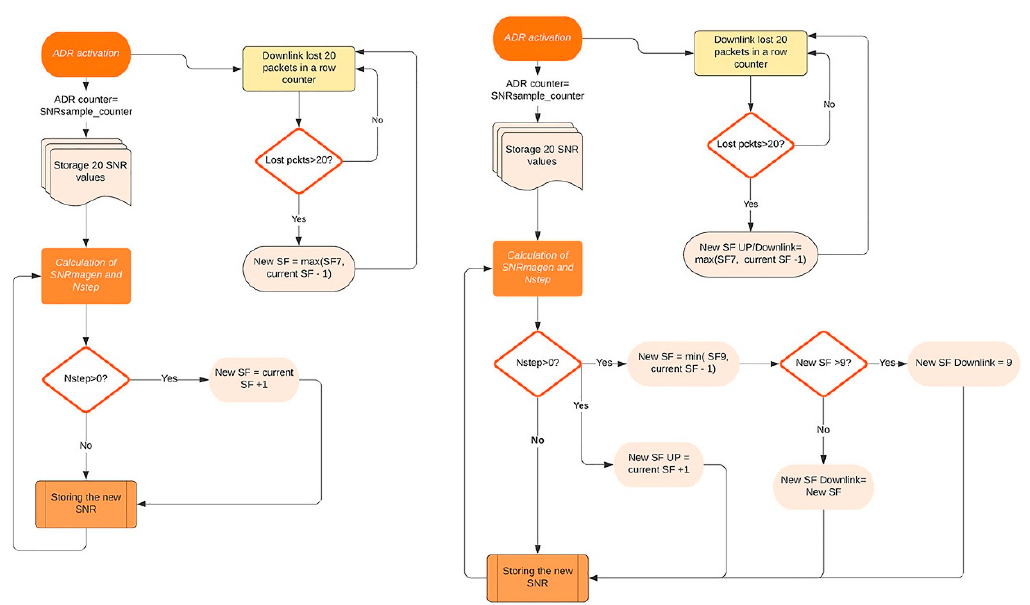
Figure 6. State machine for implemented adaptive data rate (ADR) in end device (ED) uplink (left) and gateway downlink (right).